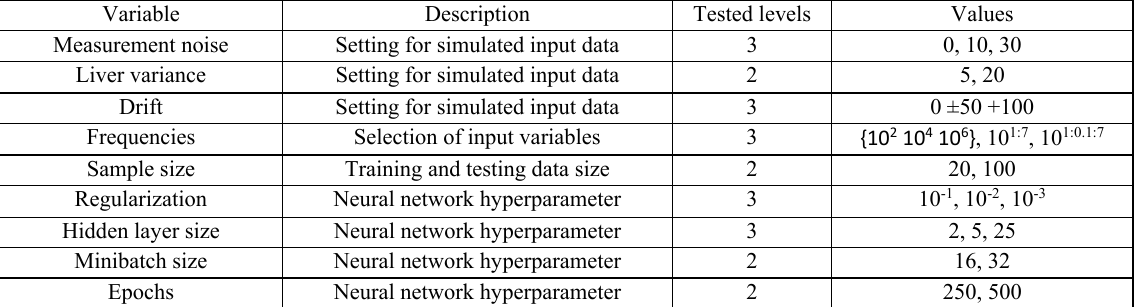
Table 1. List of all variables used for comparing different varieties of the bioimpedance input data and hyperparameters in the machine learning for prediction of ischemic